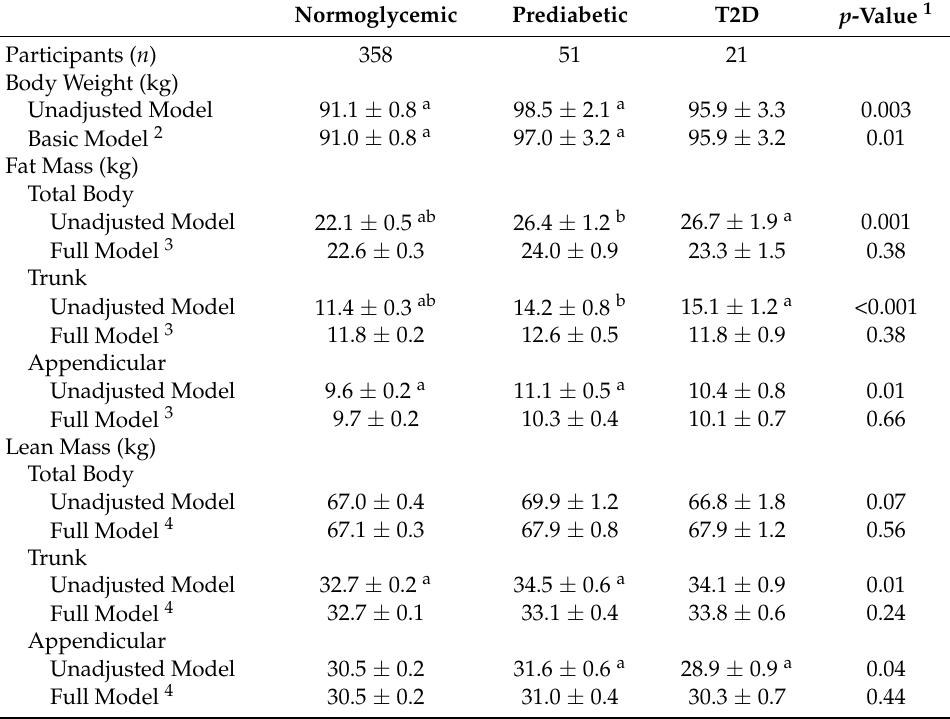
Table 3. Total body and regional body composition in the 430 men from the South Dakota Rural Bone Health Study cohort, according to glycemic status at baseline.